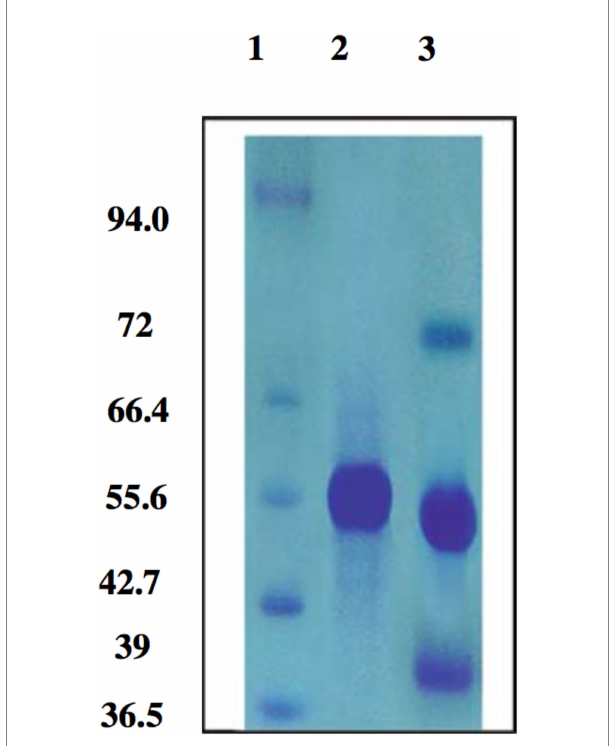
FIGURE 1 SDS-PAGE of Candida glabrata cell wall protein. Marker proteins are located in Lane 1, One pure band of 55.6 KDa in C. glabrata untreated zinc protein in Lane 2 and Zinc treated C. glabrata protein showing appearance of two new protein bands with molecular weights of 72 and 39 KDa in Lane 3 (Geweely,